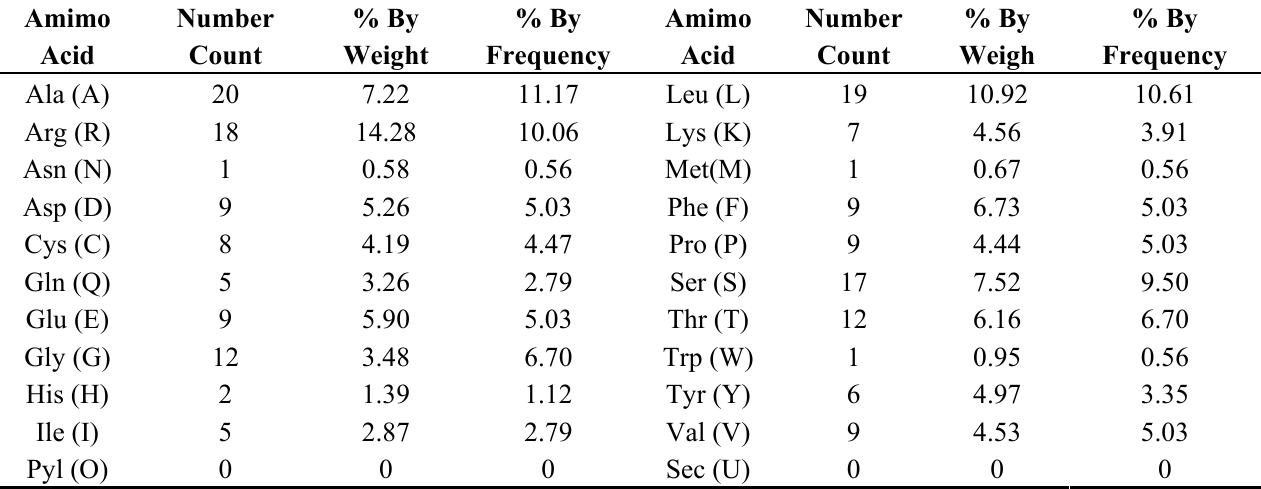
Table 1. Predicted chemical composition of the cloned fragment of